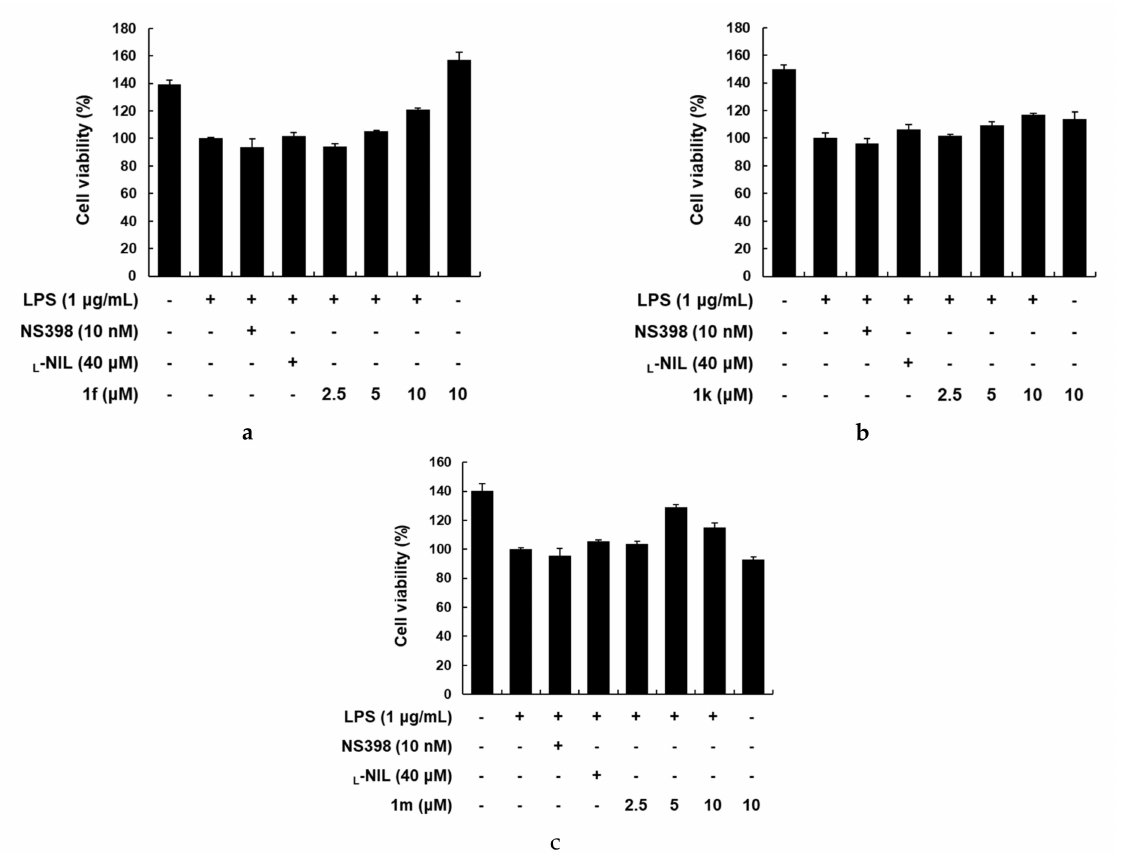
Figure 2. Effects of compounds 1f ( a ), 1k ( b ), 1m ( c ), NS398, and L -NIL on LPS-induced RAW 264.7 cell viability at various concentrations (2.5, 5, or 10 µ